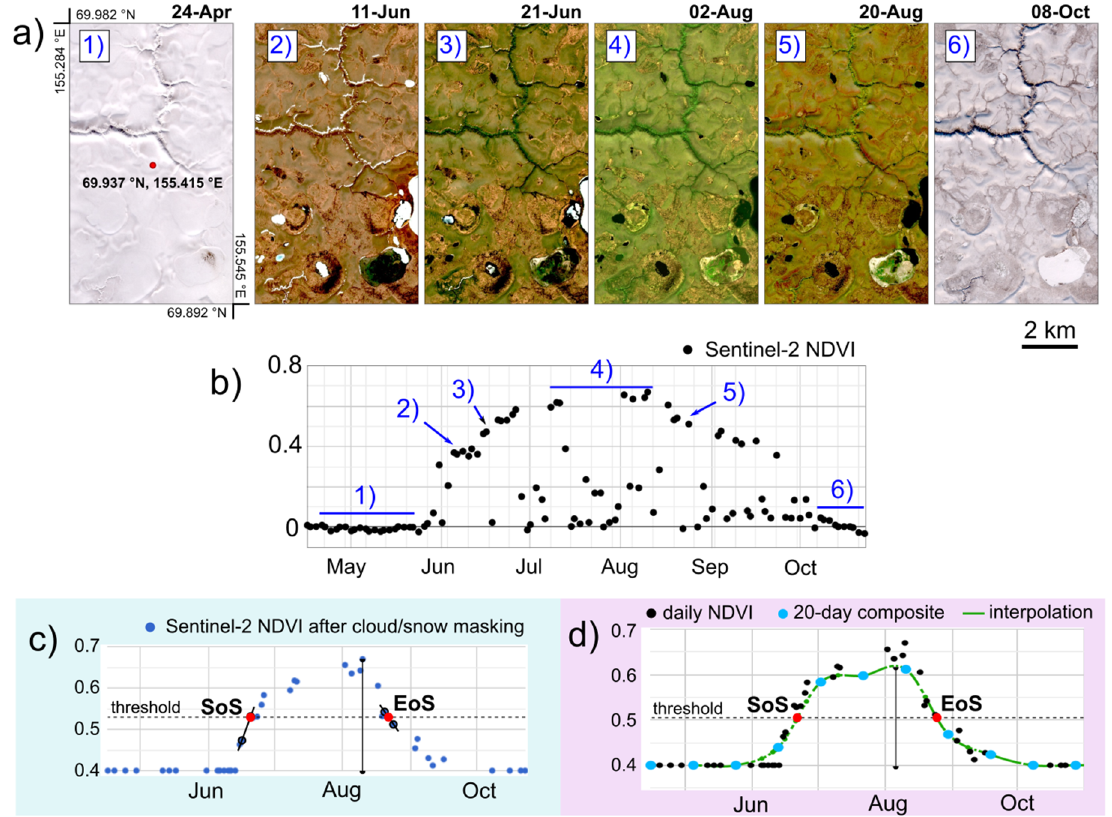
Figure 2. Illustration of vegetation dynamics for a randomly selected pixel in the Arctic. ( a ) True color compositions of Sentinel-2 time series data during 2019; ( b ) Sentinel-2 normalized difference vegetation index (NDVI) time series during 2019, with reference to true color compositions shown in ( a ); ( c ) Sentinel-2 NDVI time series after cloud masking and snow reclassification, where start of season (SoS) and end of season (EoS) correspond to the earliest and latest linearly interpolated NDVI values, respectively, above a threshold defined dynamically as 50% of the annual amplitude; and, panel ( d ) application of the threshold method over a smoothed and interpolated time series.